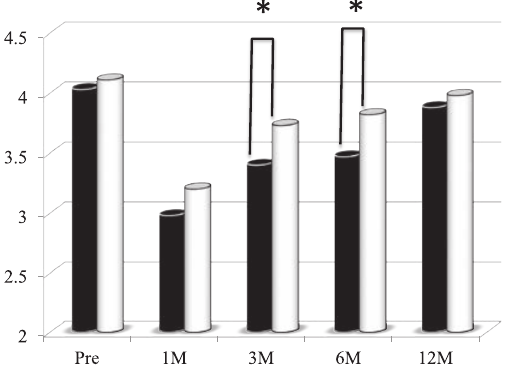
Figure 1 Changes in serum albumin concentrations in patients who underwent pancreaticoduodenectomy in the first period (with low-titer digestive enzyme preparations) versus the second period (with high-titer pancrelipase) The serum albumin concentrations at 3 and 6 months postoperatively were significantly higher in the second period group (white bar) than in the first period group (black bar). *p<0.05